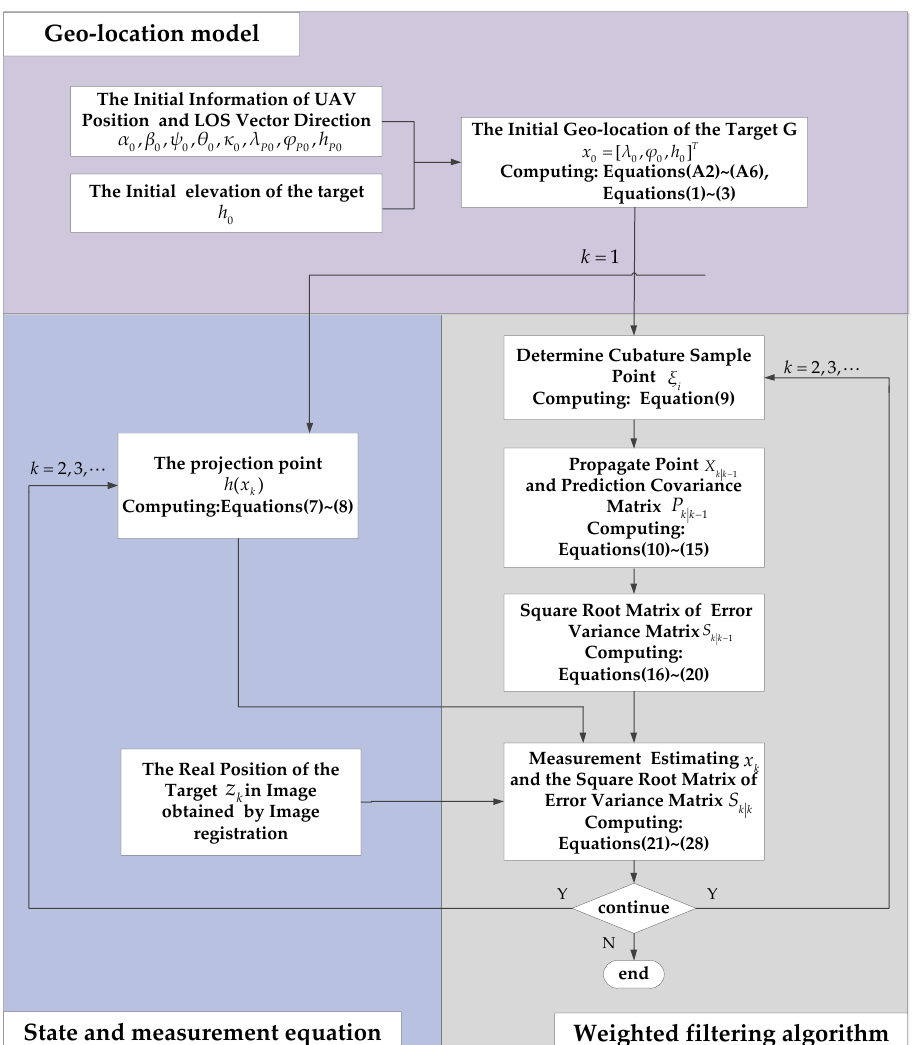
Figure 7. Flowchart of the proposed method.